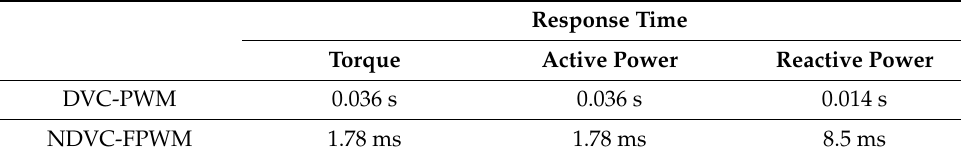
Table 1. Comparative analysis of response time.